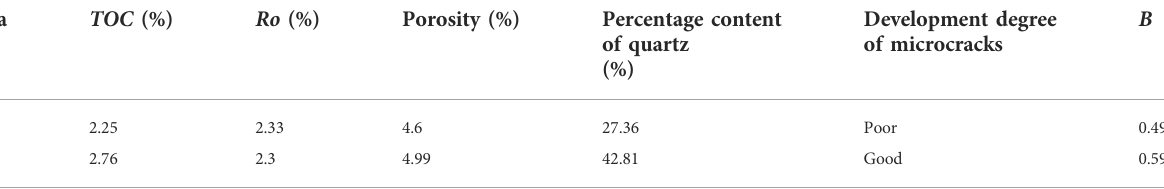
TABLE 4 Statistical results of the average value of factors affecting the fracturability of the longmaxi formation shale in the study area.